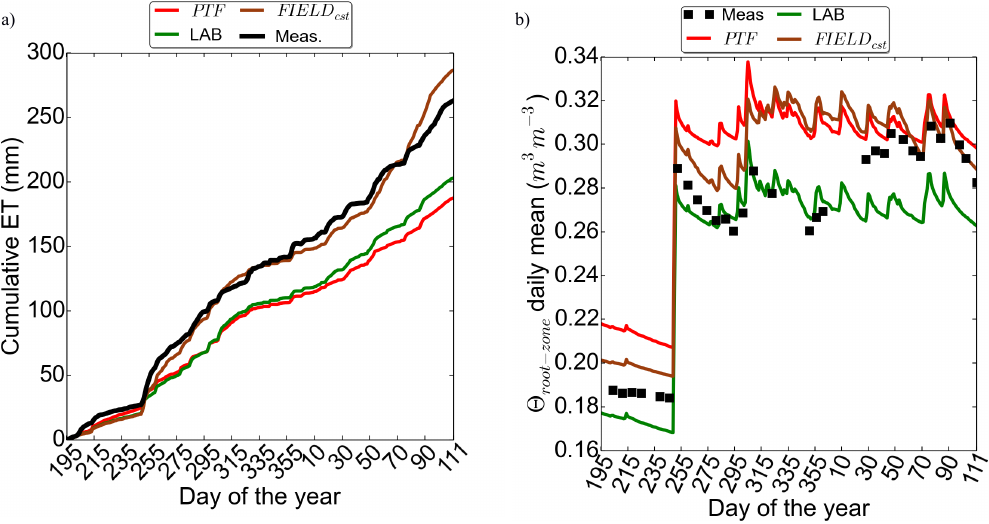
Figure 7. Evolution of (a) measured and simulated evapotranspiration (ET) and (b) measured and simulated root-zone soil moisture ( θ root-zone ) over the inter-crop period in 2010. ET corresponds to the soil evaporation since the soil is bare.